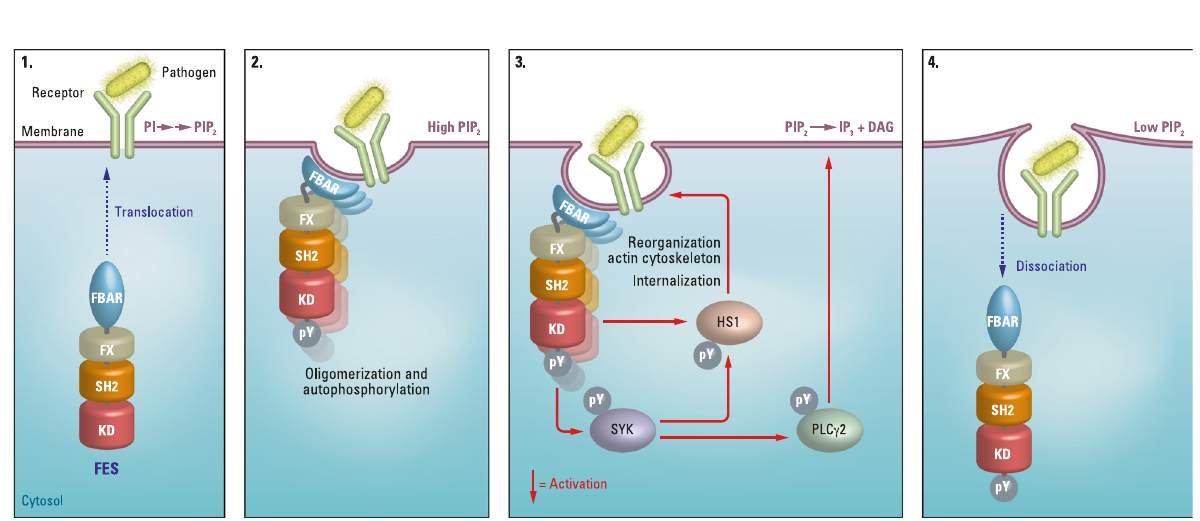
Fig. 8 Proposed model for the role of FES in neutrophil phagocytosis via SYK-HS1-PLC γ 2 pathway activation. Representations are simpli fi ed for illustration